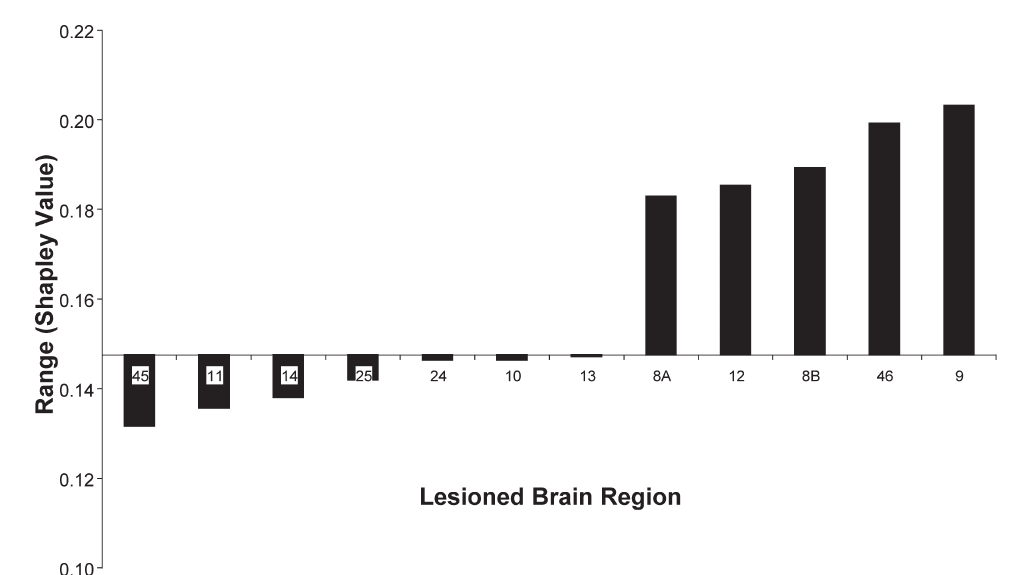
Figure 7. Range of Shapley values in increasing order for different eliminated brain regions (abscissa) calculated as the difference between the highest and lowest values among the remaining nodes from the W40-2 matrix. The level of the abscissa indicates the range value in the intact network.